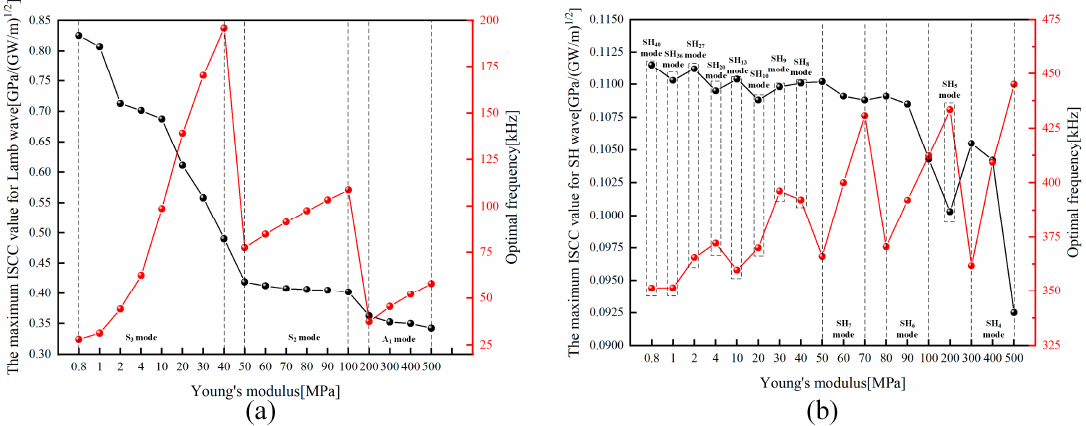
Figure 5. Effect of Young’s modulus of coating on maximum ISCC value and optimal frequency: ( a ) Lamb waves; ( b ) SH waves.